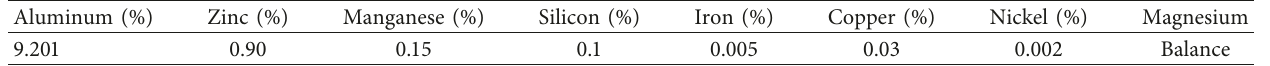
Table 1: Composition of AZ91D magnesium alloy.